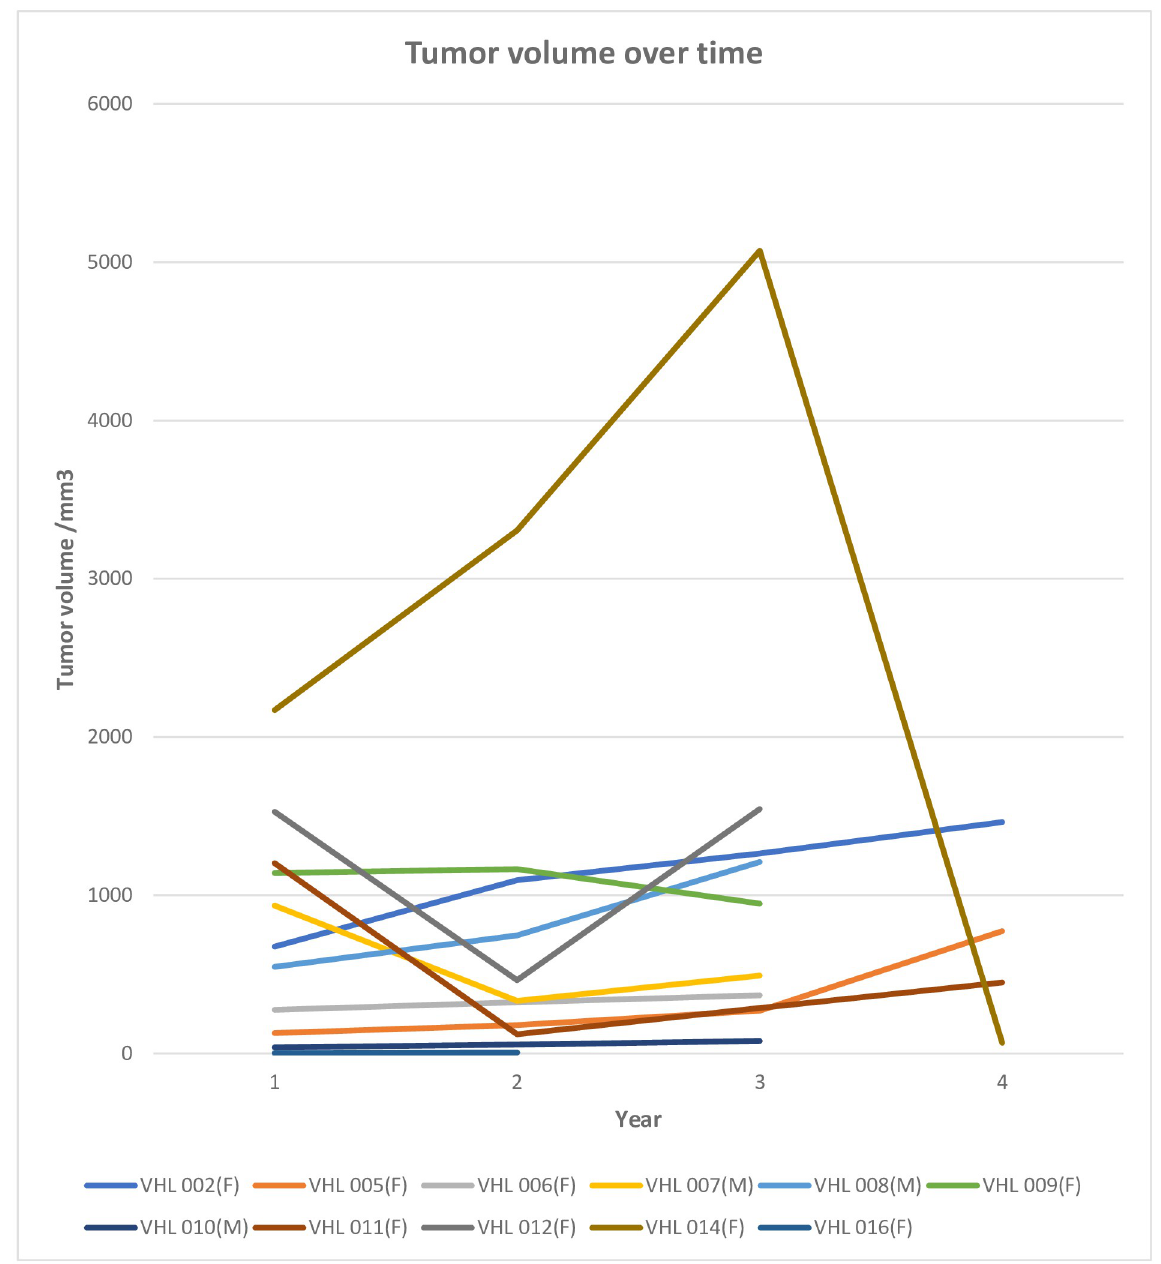
Fig 1. Tumor volume increase over time. Note the differing growth patterns. Dramatic increases seen most often pertained to increased size of one single tumor. Only patients with more than one completed MRI-investigation are shown. Decrease in volume was only seen in patients who had undergone surgery. VEGF was analyzed at initial visit (year 0) in all